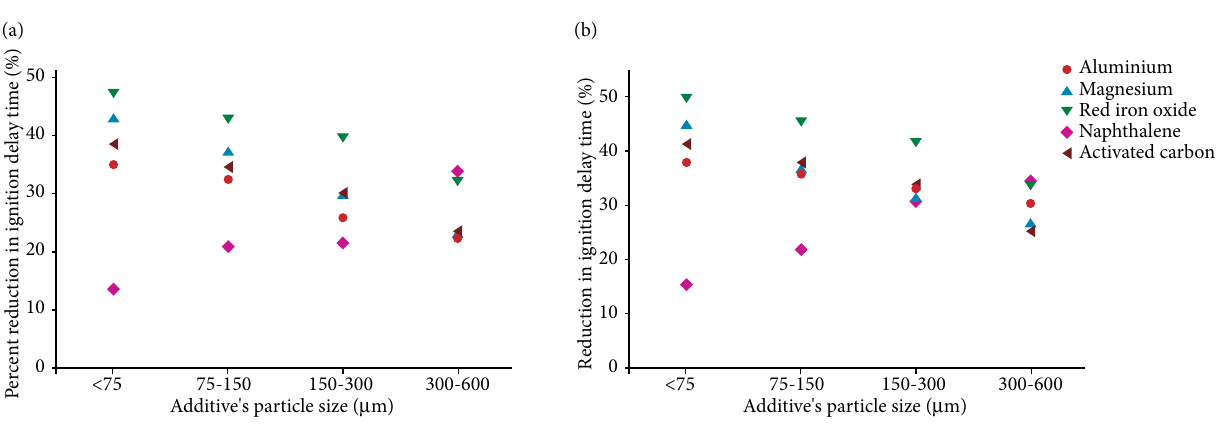
Figure 4. Reduction in ignition delay time (a) 3%, and (b)